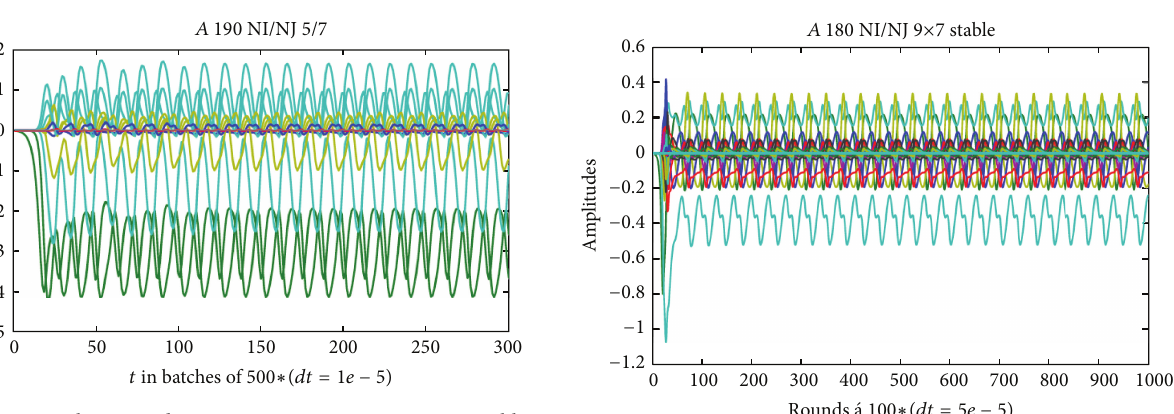
Figure 4: Simulation grids NI × NJ = 7 × 5 . 𝑅 periodic motion to 𝑡 = 1.5 . Table 3: Average of amplitudes, 𝑅